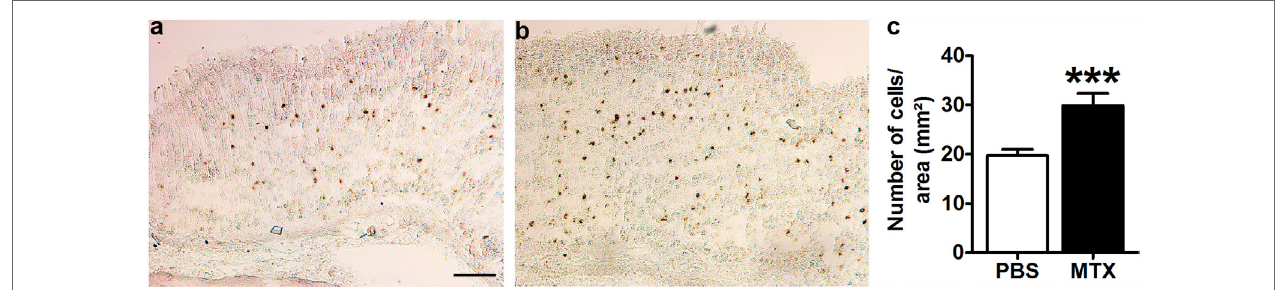
FigUre 2 | representative microphotographs of preproghrelin mrna-expressing cells in the stomach of PBs-treated control rats ( n = 10) (a) and MTX-treated rats ( n = 7) (B) revealed by in situ hybridization with Dig-labeled preproghrelin anti-sense riboprobes . (c) Quantification of the number of preproghrelin mRNA-positive cells in the gastric mucosal and submucosal layers of control and MTX-treated rats. Student’s t -test, *** p < 0.001, KS test p > 0.1 both (mean ± SEM). Scale bar, 100 μ